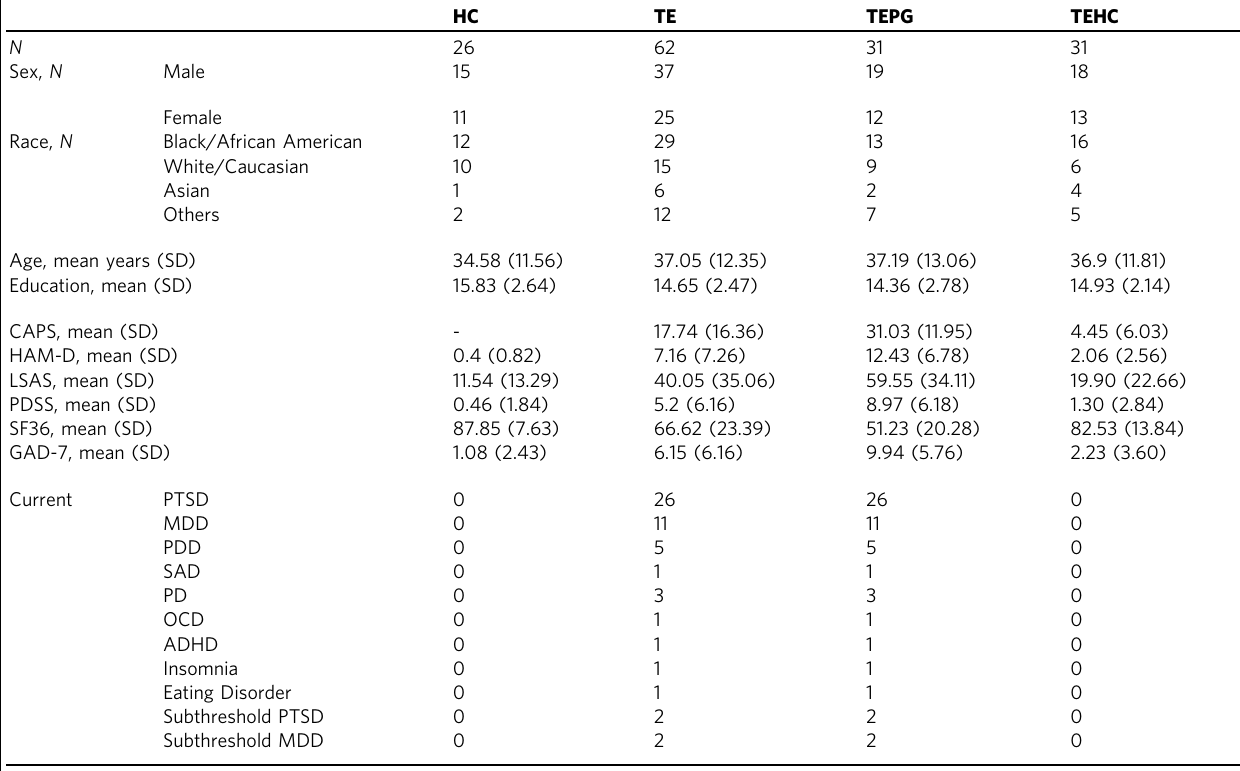
Table 1 Demographic information of the